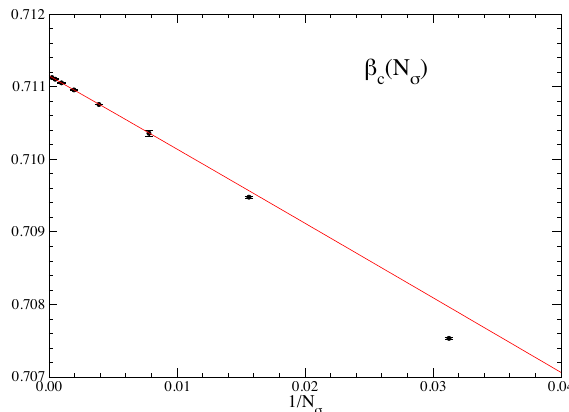
Figure 10 . Peak position of the speci(cid:12)c heat (cid:12) c ( N (cid:27) ) at N (cid:28) = 3 as a function of 1 =N (cid:27) . Solid curve represents the (cid:12)t result.